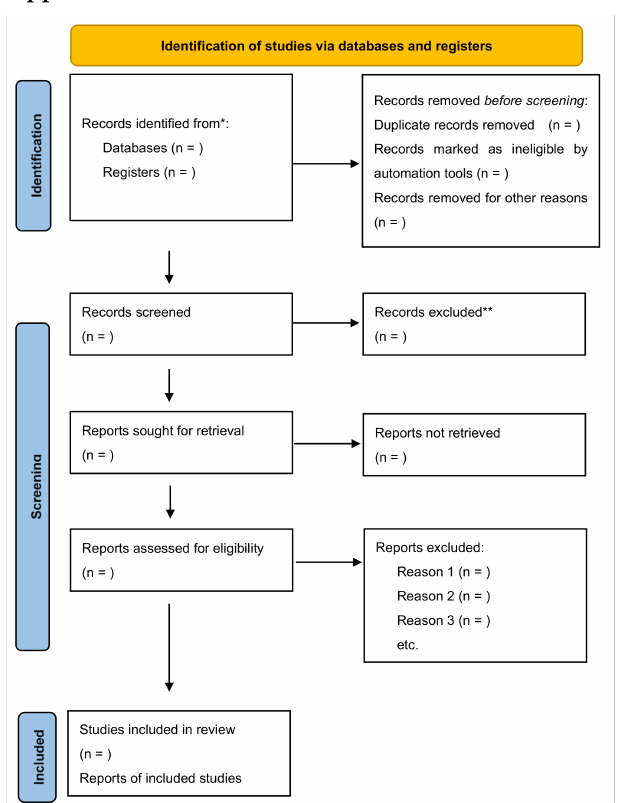
Figure A1. PRISMA 2020 Checklist. * Consider, if feasible to do so, reporting the number of records identified from each database or register searched (rather than the total number across all databases/registers). ** If automation tools were used, indicate how many records were excluded by a human and how many were excluded by automation